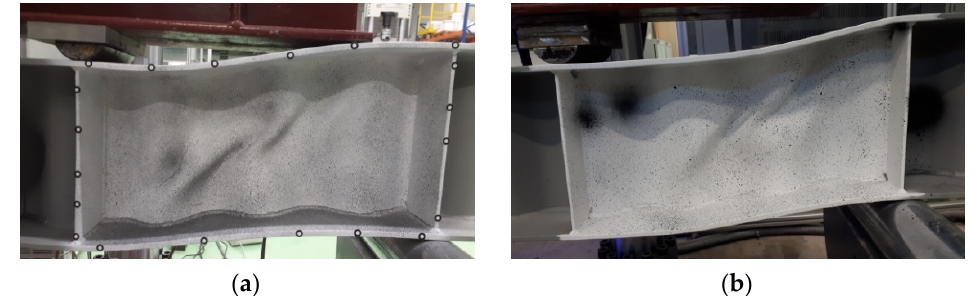
Figure 11. Forms of failure of BS 155 beams with a 3 mm-thick web: ( a ) pilot beam and ( b ) main beam.